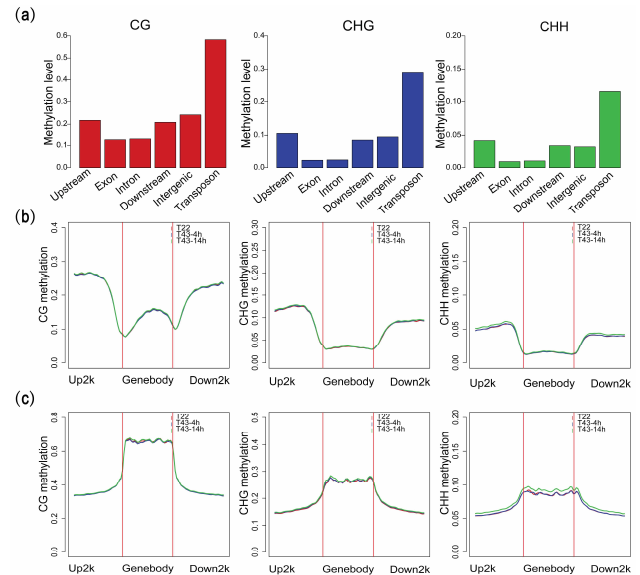
Figure 2. Methylation patterns of different annotated categories. ( a ) Methylation levels of different genome annotated categories; ( b ) distribution of methylation along protein-coding genes; ( c ) distribution of methylation along transposable elements (TE). Two vertical red lines mark the gene and TE boundaries. Methylation levels of upstream and downstream 2000 bp are also shown.